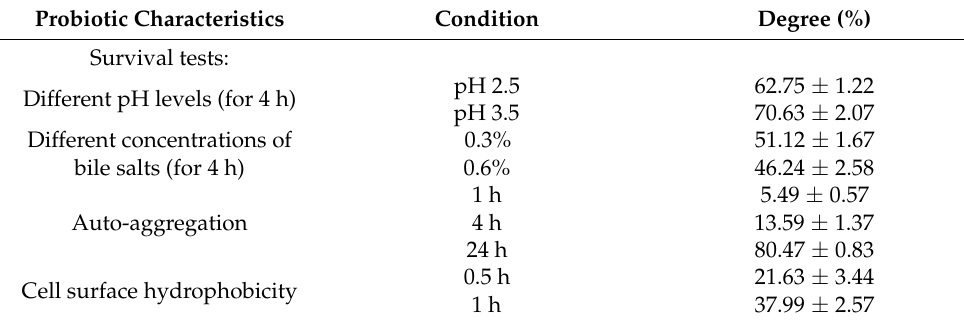
Table 1. Probiotic characteristics of B . subtilis T5.